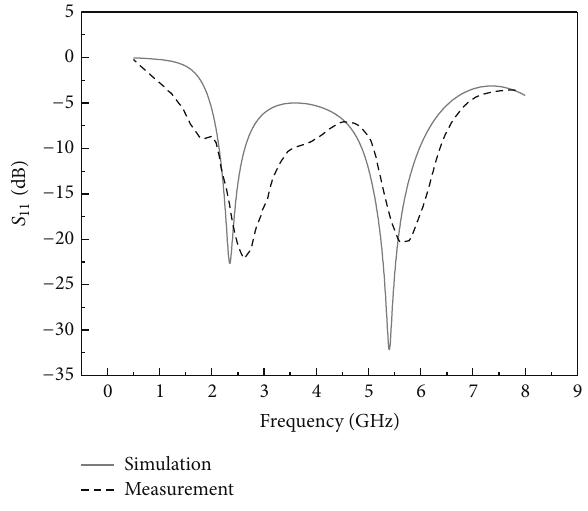
Figure 4: Comparison between the simulated and measured return losses for proposed